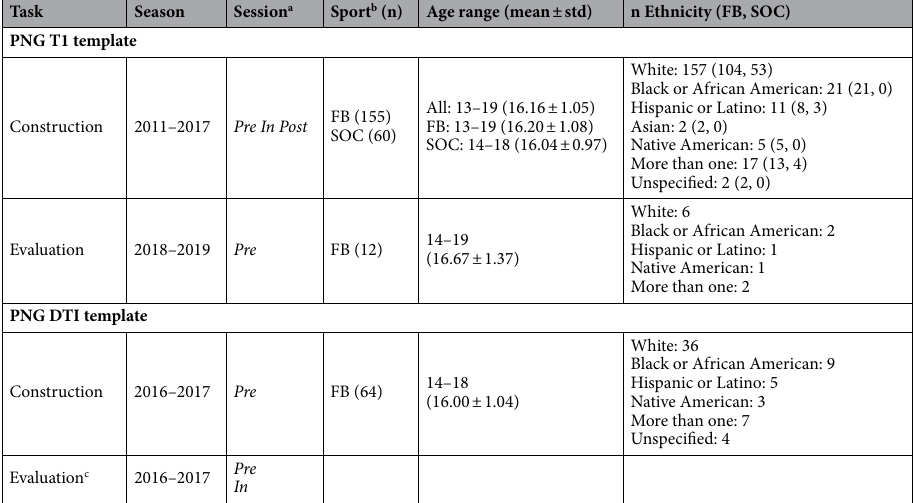
Table 4. Summary of the datasets for constructing and evaluating the population-specific T1 and DTI templates, based on the Purdue Neurotrauma Group (PNG) longitudinal MRI database 50 . a Data were acquired across multiple sessions, including one approximately one month before contact practices began ( Pre ), one or more within competition season ( In ), and one or more after the season ended ( Post ). b All football athletes (FB) are male participants, and all soccer athletes (SOC) are female participants. c Same sport, age range, and ethnicity as the dataset for constructing the DTI